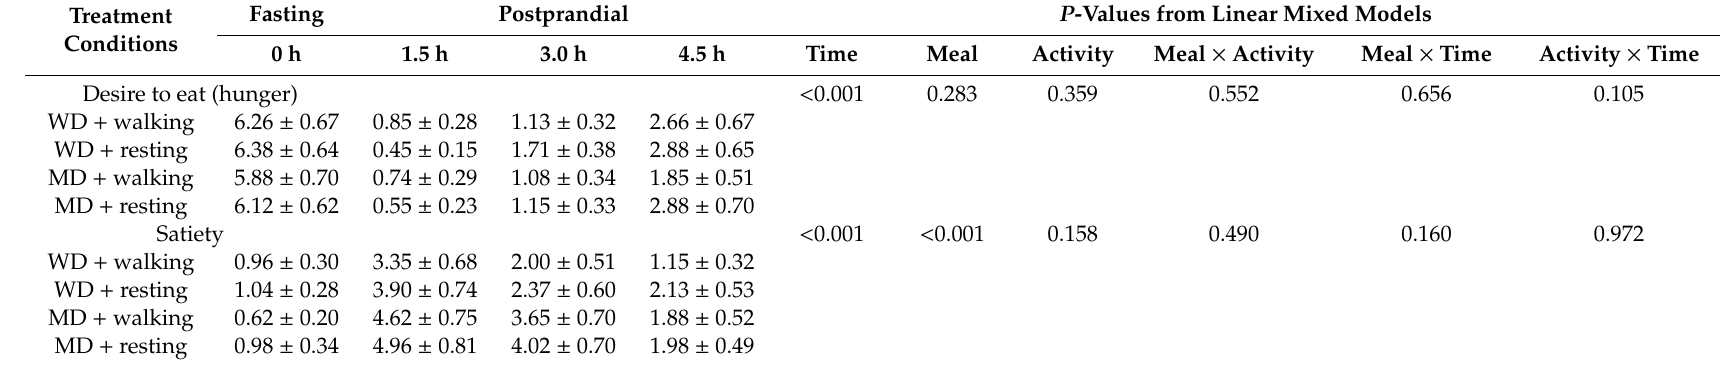
Table 5. Fasting and postprandial hunger and satiety 1,2.